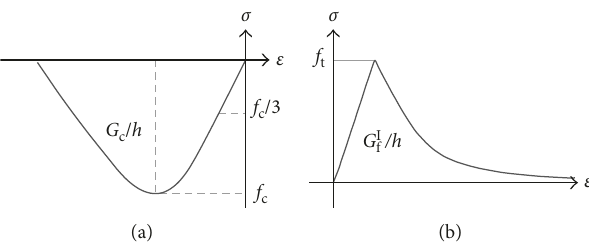
Figure 5: Stress-strain relationships adopted for the total strain rotating crack model: (a) compression; (b) tension.